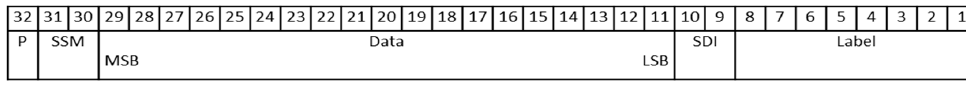
Figure 5. Format of an ARINC 429 message–derived from [6] (p. 34-4).